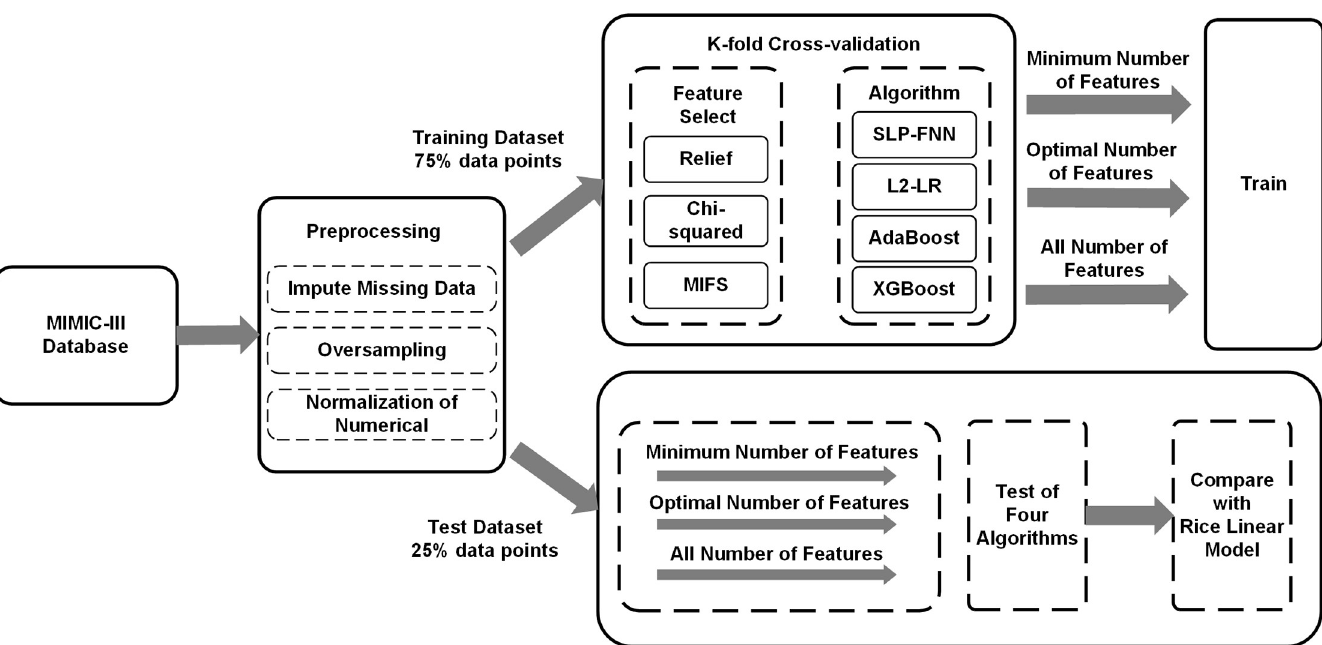
Fig 1. Overview of the model design. Summarize the overall process of the experiment. The raw data in the MIMIC-III database was preprocessed, and the data set was awakened and randomly grouped: 75% data was used for model training; the remaining 25% data was used for model testing, and comparative experiments were conducted to obtain the final experimental